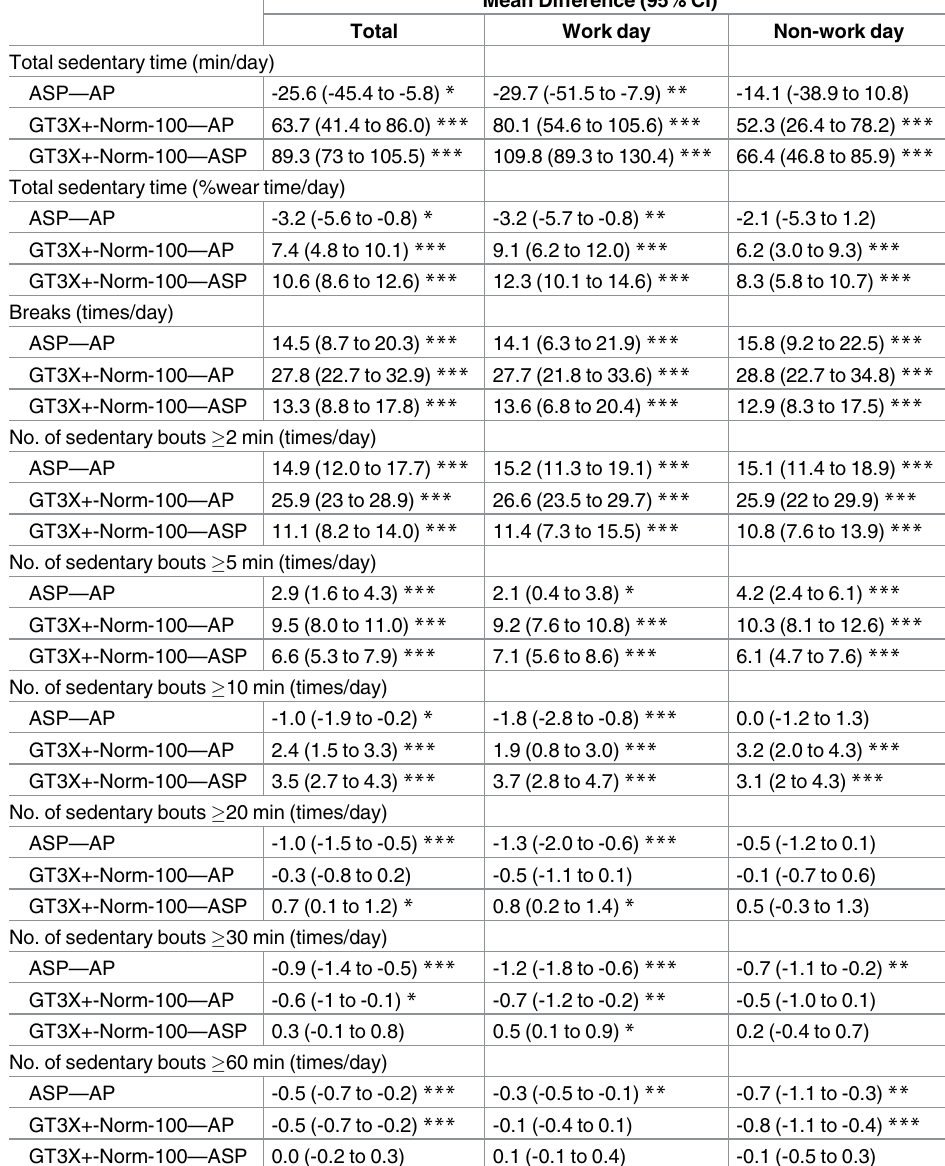
Table 2. Mean differences in sedentary outputs between ASP, GT3X+-Norm-100, and AP by working